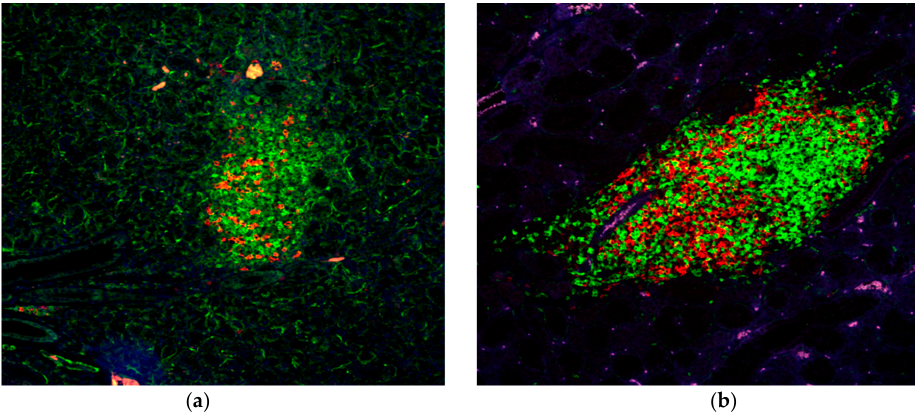
Figure 1. Histological photomicrographs depicting lymphocytic infiltrations (lymphocytic foci (LF)) present within the salivary glands of both C57BL/6J ( a ) and C57BL/6.NOD- Aec1Aec2 mice ( b ) at 7 months of age. While the infiltrations within the salivary glands of both mouse strains contain both T cells (green fluorescence) and B cells (red fluorescence), both the transcriptomes and immunological activities are very different from each other. During the early disease stages, LF of our SS S mice contain higher numbers of B cells; however, at later stages, the T lymphocyte population(s) tend to overtake the number of B lymphocytes. In addition, the LF of the SS S mice are strongly periductal.